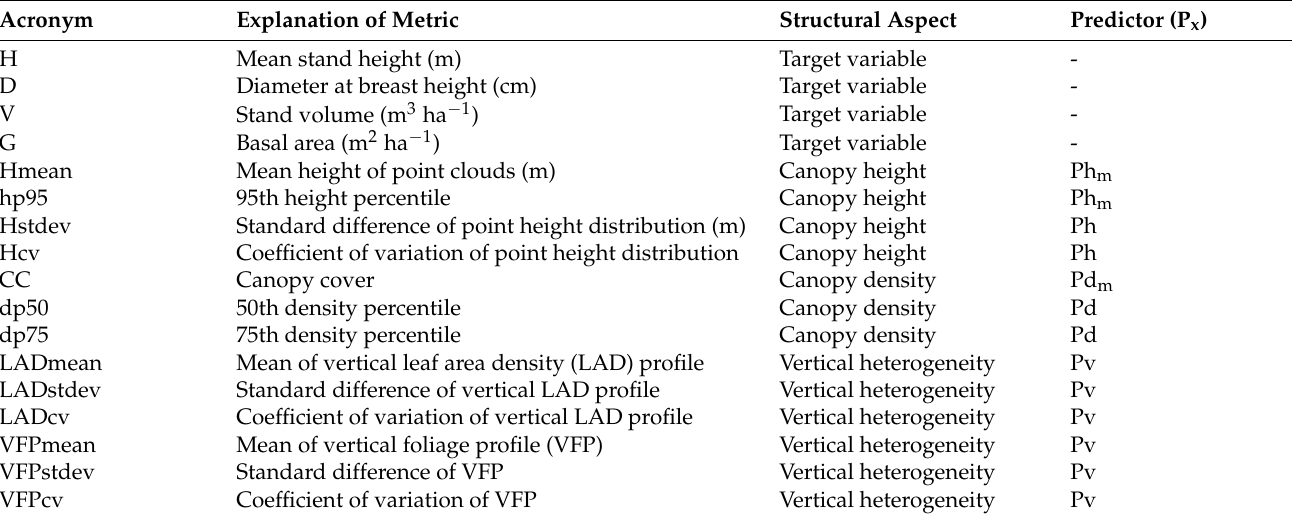
Table 2. List of LiDAR-derived metrics used in the establishment of the prediction